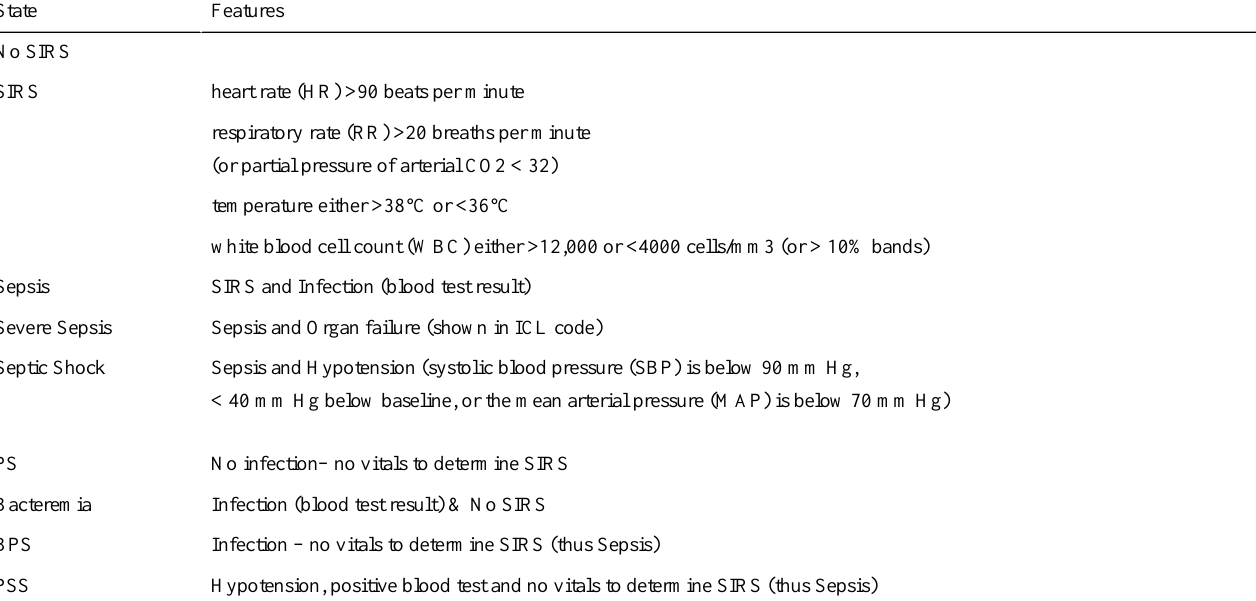
Table 2. States and their definition based on vitals and blood